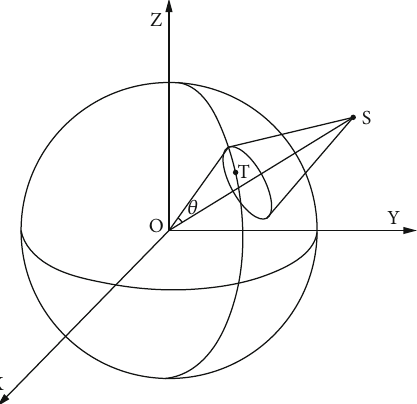
Figure 2: Schematic diagram of single satellite ’ s ground